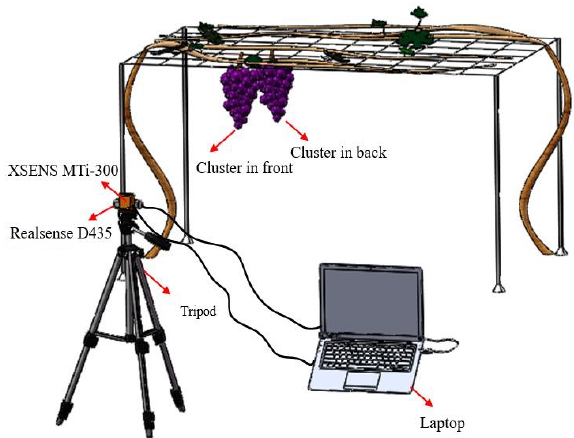
Figure 19. Images captured with different camera tilt angles.